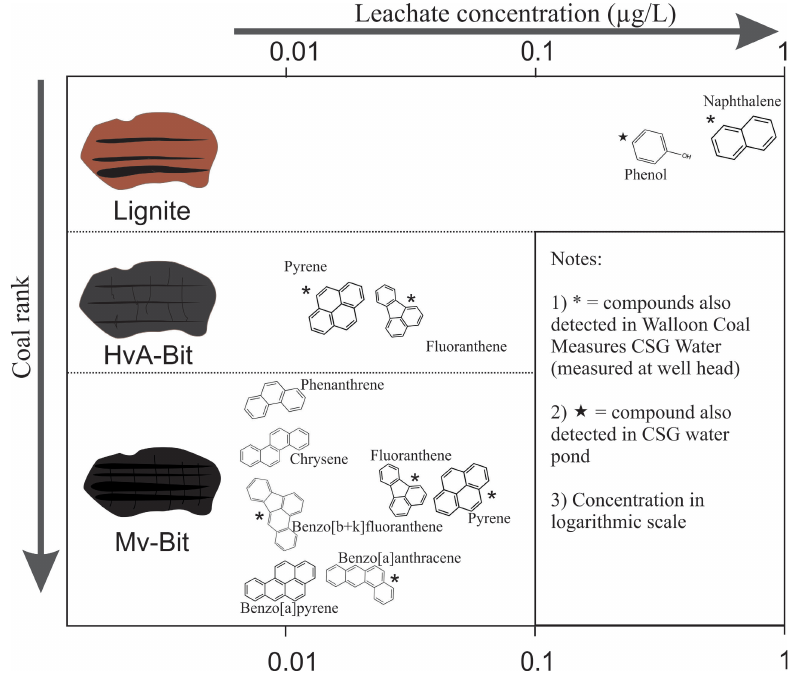
Figure 2. Aromatics (mostly PAHs) leached from coal samples with deionized water and their relative concentrations. PAHs reported from Walloons CSG water samples are also